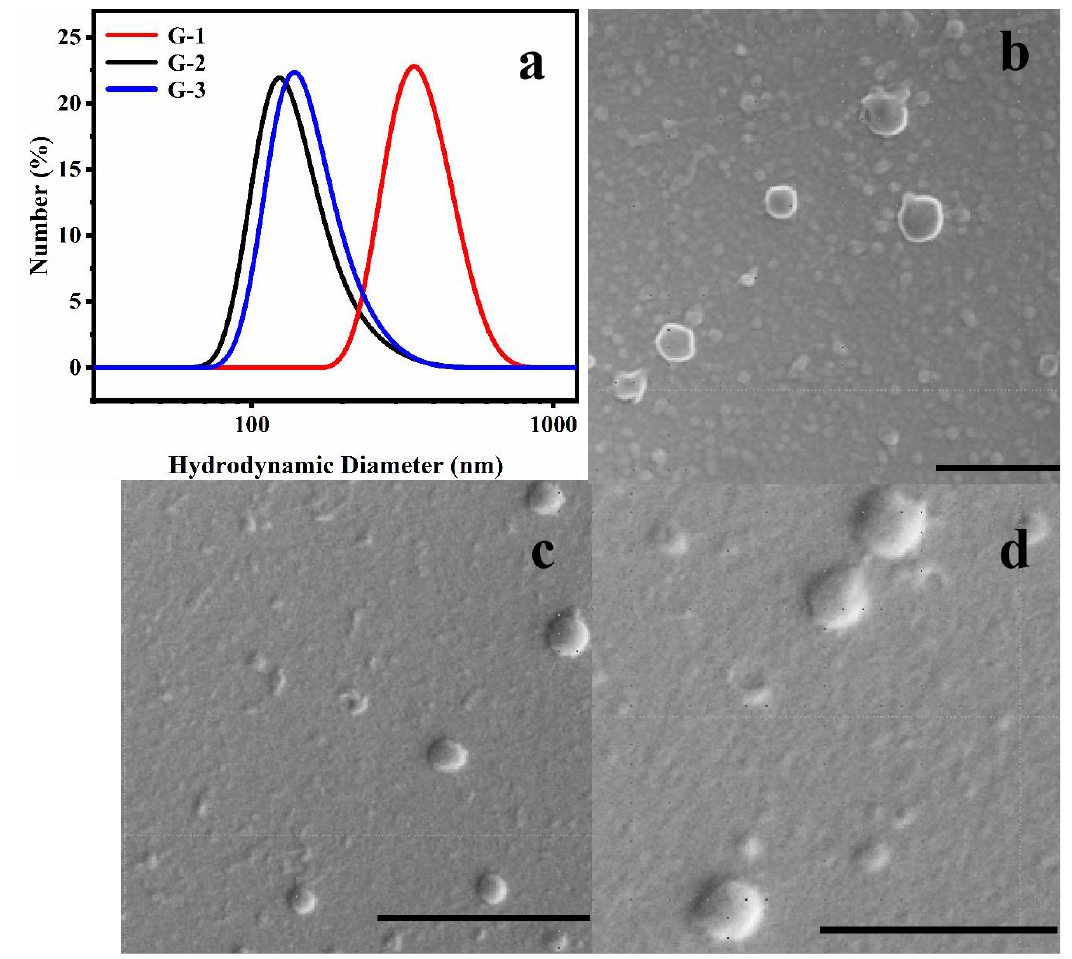
Table 5. Structure data of the lysozyme modified bioconjugates and DLS results of their self-assem- blies.